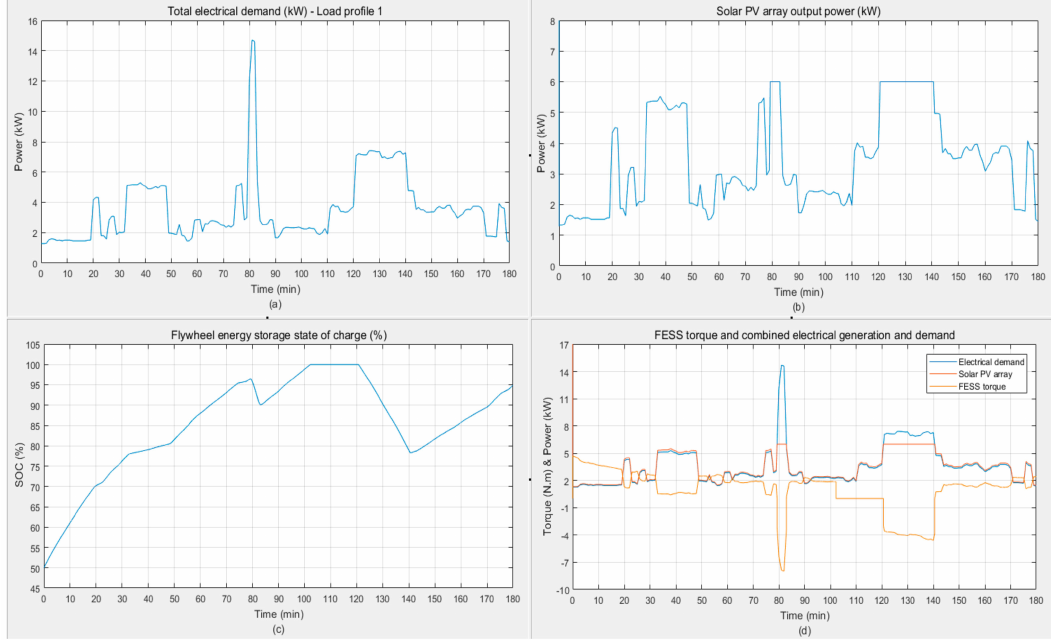
Figure 19. ( a ) Load profile 1. ( b ) PV array output power. ( c ) Flywheel state of charge. ( d ) Flywheel torque, combined generation, and